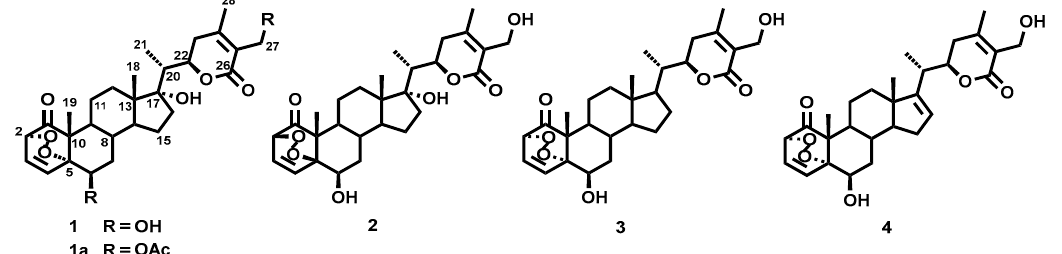
Figure 1. Chemical structures of withaperoxidins A–D ( 1 – 4 ) isolated from Withania aristata .